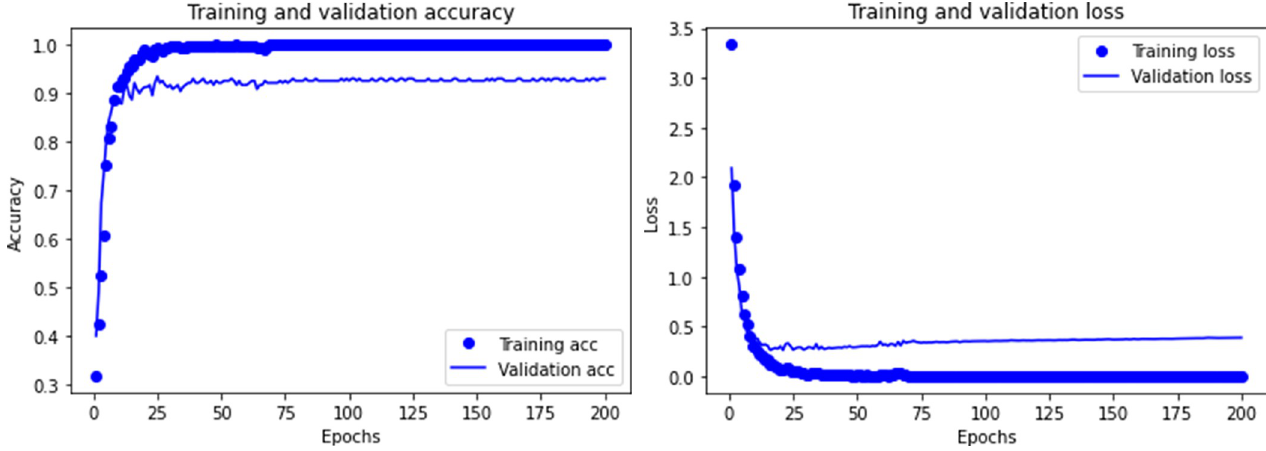
Fig 7. Accuracy and loss of CNN model when training 200 times.